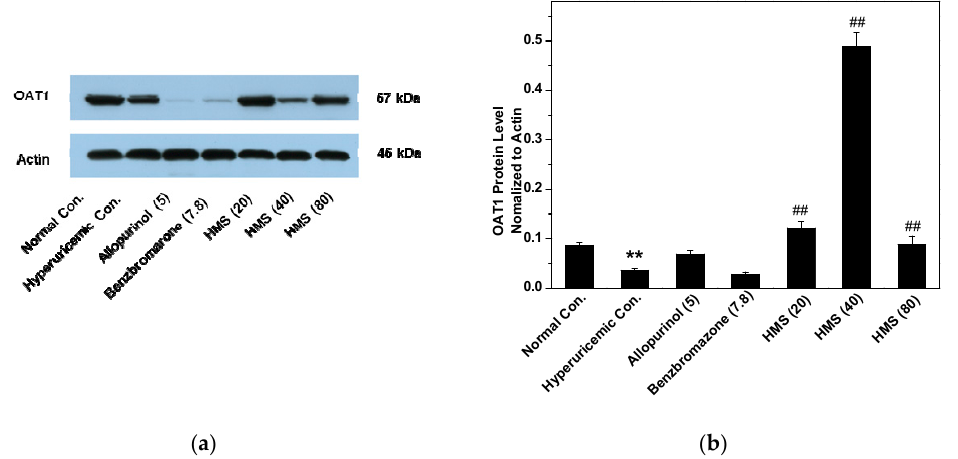
Figure 8. Protein levels OAT1 in kidney: ( a ) Western blot bands; ( b ) the contents determined through densitometry and normalized to actin. Data were expressed as mean ± SD; n = 3. Statistical analysis by one-way ANOVA followed by two-tailed Student’s t -test; ** p < 0.01 versus the normal control; ## p < 0.01 versus hyperuricemic control.